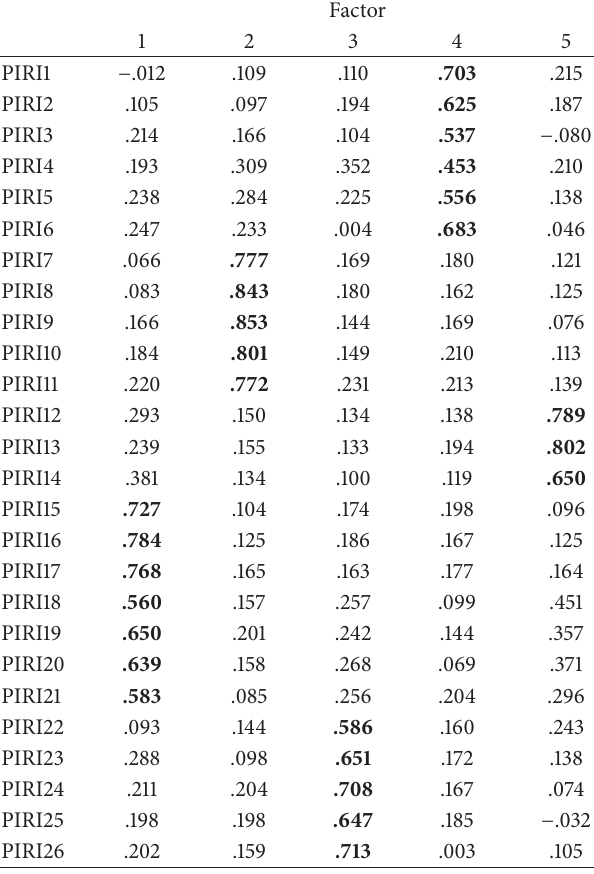
Table 2: Rotated matrix of components, 5-factor solution. Items correlated with the specific factor are evidenced in bold.